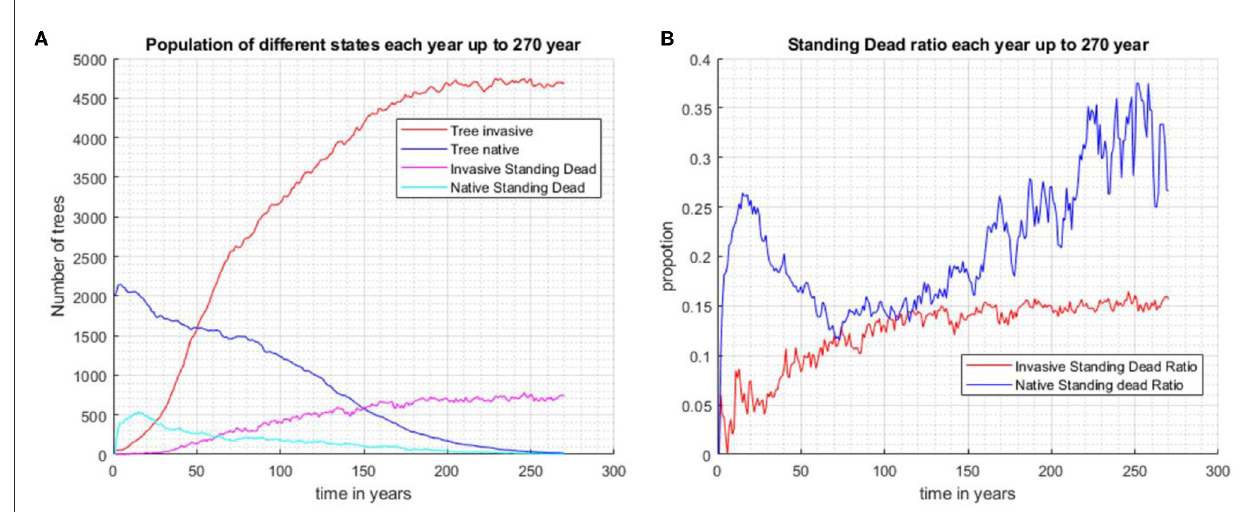
FIGURE4 When the two species are randomly distributed across the same area initially and without biocontrol in the system, the invasive species outcompetes and occupies the entire plot after approximately 200 years (Scenario 2). (A) Population of invasive trees, native trees, invasive standing stand stems, and native standing dead stems. (B) The proportions of standing dead and the total population of each species.